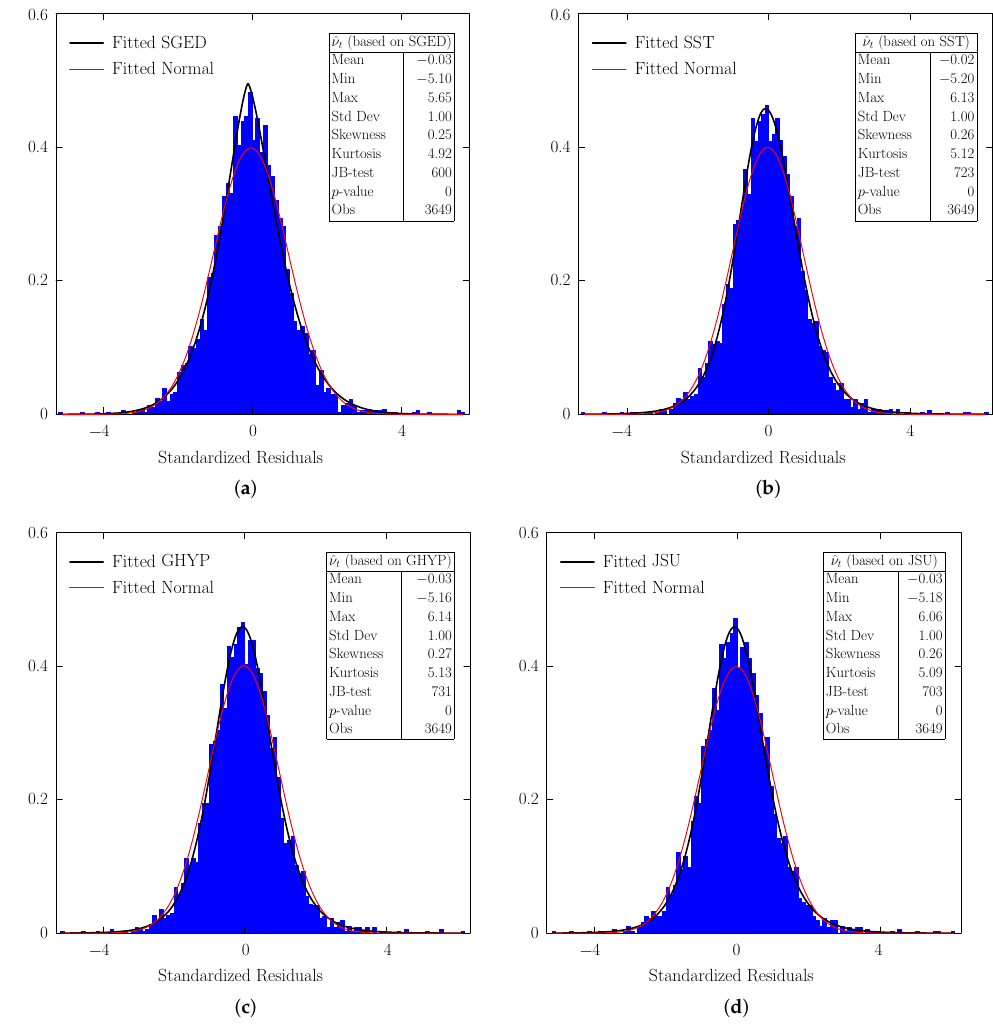
Figure 6. Empirical, fitted theoretical, and fitted normal distributions of standardized residuals ˆ ν t .